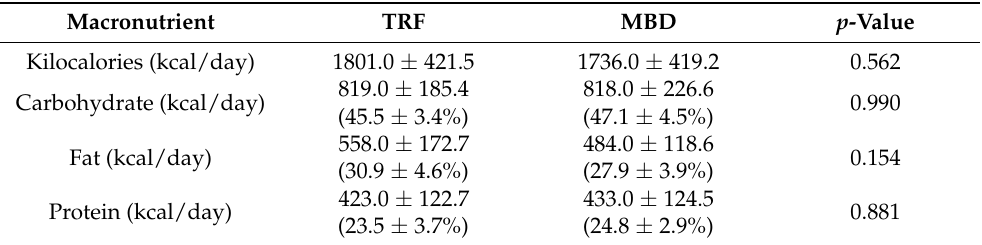
Table 2. Distribution of macronutrients and total calorie intake of the TRF and MBD group during phase